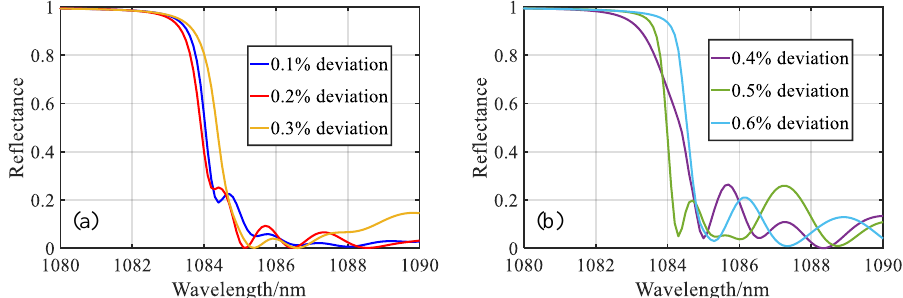
Figure 5. The reflectance curves of the edge filter with various random errors on each layer of the stack: ( a ) 0.1%~0.3%; ( b ) 0.4%~0.6%.